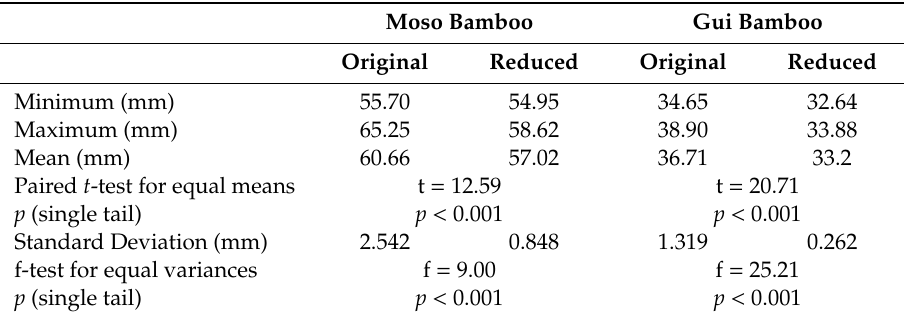
Table 1. Comparison of means and variances of outer diameters before and after reducing.